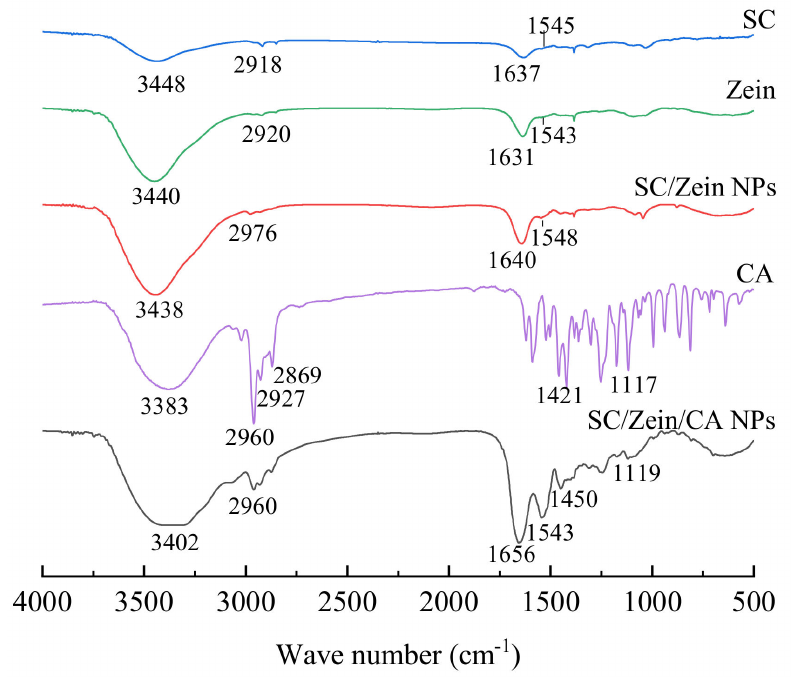
Figure 1. FT-IR spectra of SC, zein, SC/zein NPs, CA, and SC/zein/CA